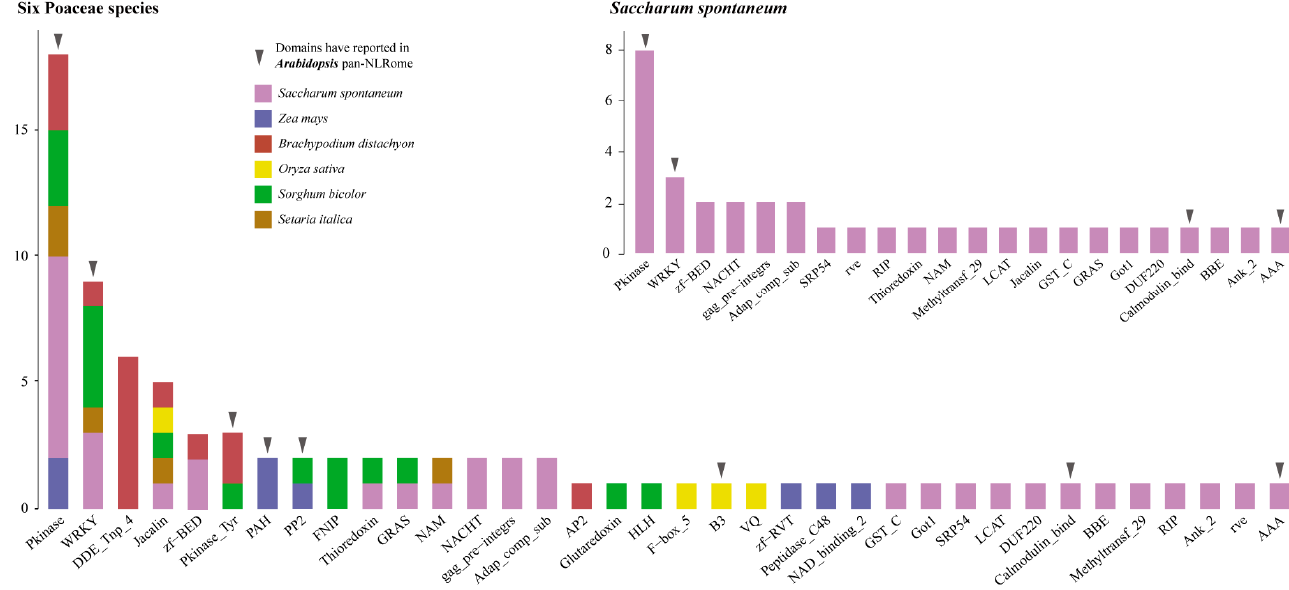
Figure 1. A total of 45 distinct Pfam domains were identified in the six Poaceae species involving 85 NLRs and 28 distinct Pfam domains were identified in Saccharum spontaneum .